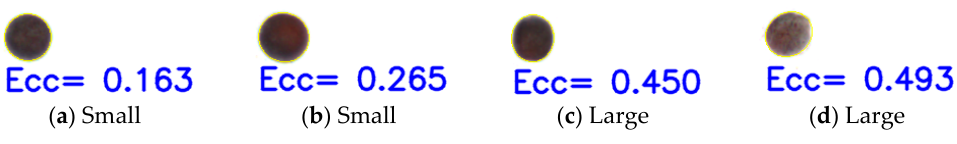
Figure 6. Eccentricity comparison.